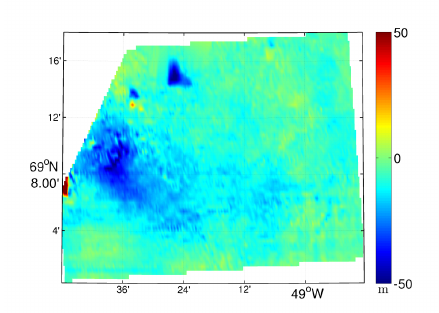
Fig. 7. Gravity changes calculated using the Gravsoft TC program from 04.08.2007 to 02.08.2008. The area shown corresponds to the region of Jakobshavn Isbræ glacier shown in Fig. 5.